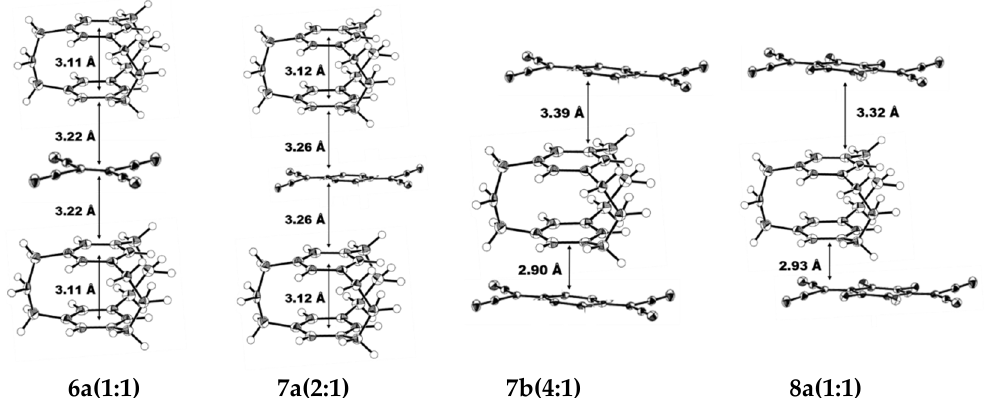
Figure 5. ORTEP drawings of complexes 6 , 7 , and 8 at − 180 °C (the probability of thermal ellipsoid is 50%).